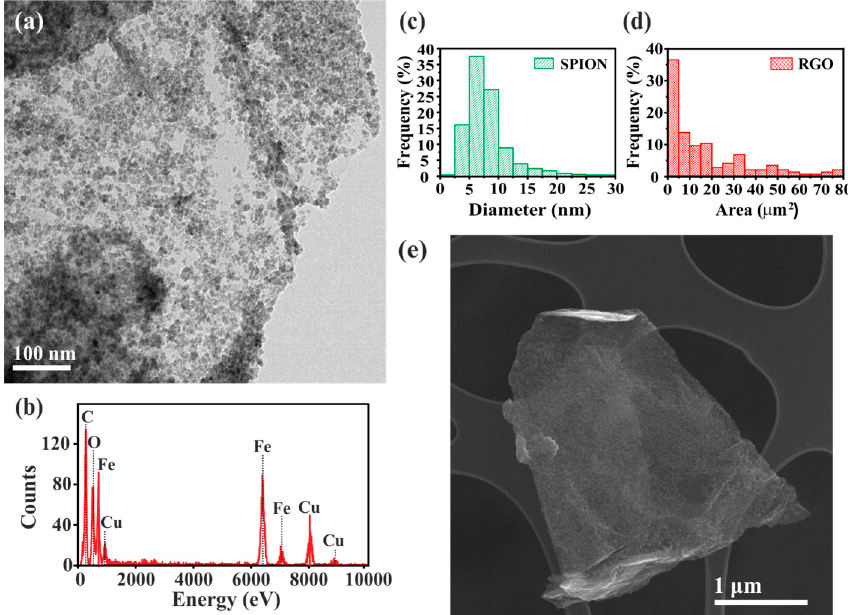
Figure 1. Electron microscopy characterization of the SPION-RGO composites. ( a ) TEM image of SPION-RGO sample prepared by microwave-assisted decomposition of iron (III) acetylacetonate in the presence of graphene oxide. ( b ) EDX analysis confirming the presence of Fe in the sample (from SPION) along with C (from the RGO). Cu signal arises from the support employed for the analysis. Histograms showing ( c ) the particle size distribution of the SPION decorating the RGO surface and ( d ) the area of the RGO sheets. ( e ) Representative SEM image of the SPION-RGO sample.